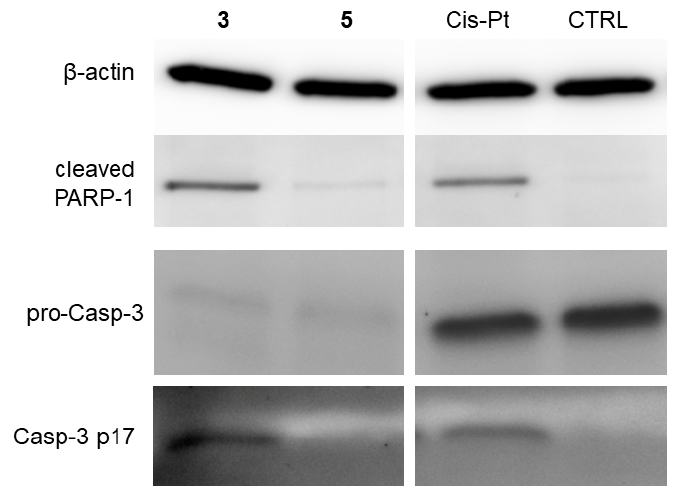
Figure 5. The levels of apoptosis-related proteins. THP-1 cells were treated by complexes 3 and 5 at the concentration of 4 μ M and by cisplatin (Cis-Pt) at concentration of 10 μ M for 24 h. Then, the amount of proteins was detected by Western blot and immunodetection. Present immunoblots show the results of pooled four independent reactions. CTRL = the cells treated only by 0.1% DMF (control cells).